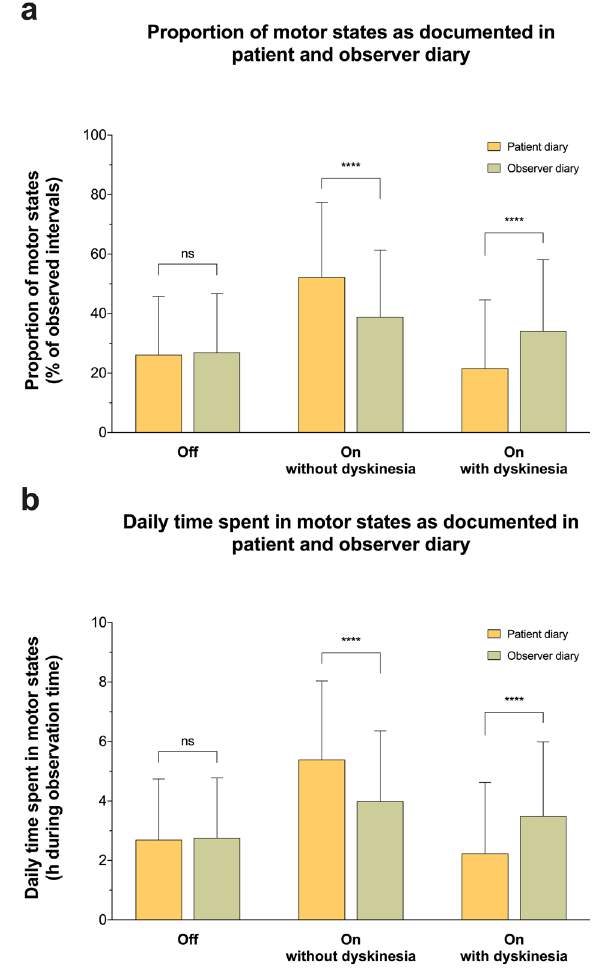
Fig. 1 Proportion of motor states assessed by patient and observer diaries. a The mean proportions of Off, On without dyskinesia and On with dyskinesia based on 1997 simultaneous, half-hourly performed diary ratings from 51 patients with Parkin- son ’ s disease (yellow colour) and an independent clinical observer (green colour). b Illustrates the daily time spent in the respective motor states during the observation period as documented on the patient (yellow colour) and on the observer diary (green colour). Values are provided as means + standard deviation. **** P < 0.0001 from Wilcoxon matched-pairs signed rank tests. ns not signi fi P < 0.001) and less On time with dyskinesia (2.2 h vs. 3.5 h, P < 0.001) than the observer, whereas Off time was similar between